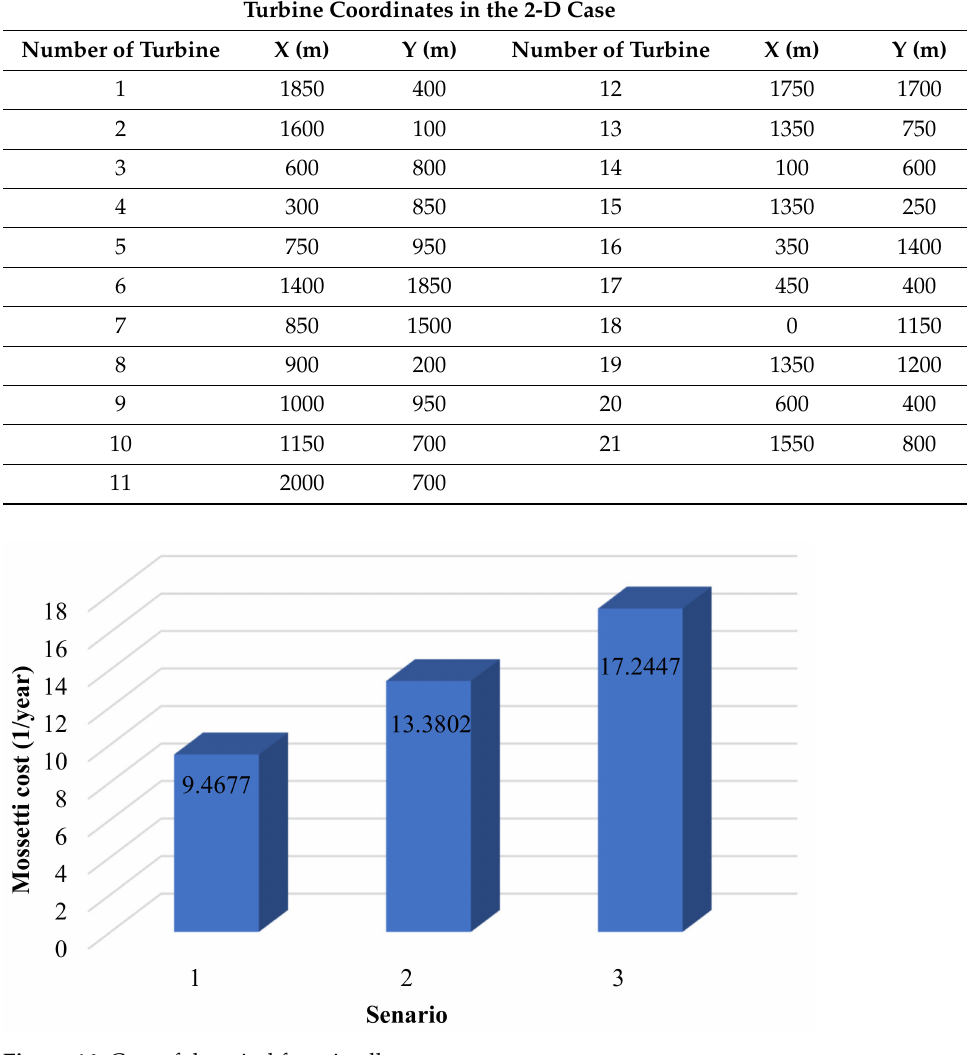
of turbines. The reason is that the objective function is defined as the cost per